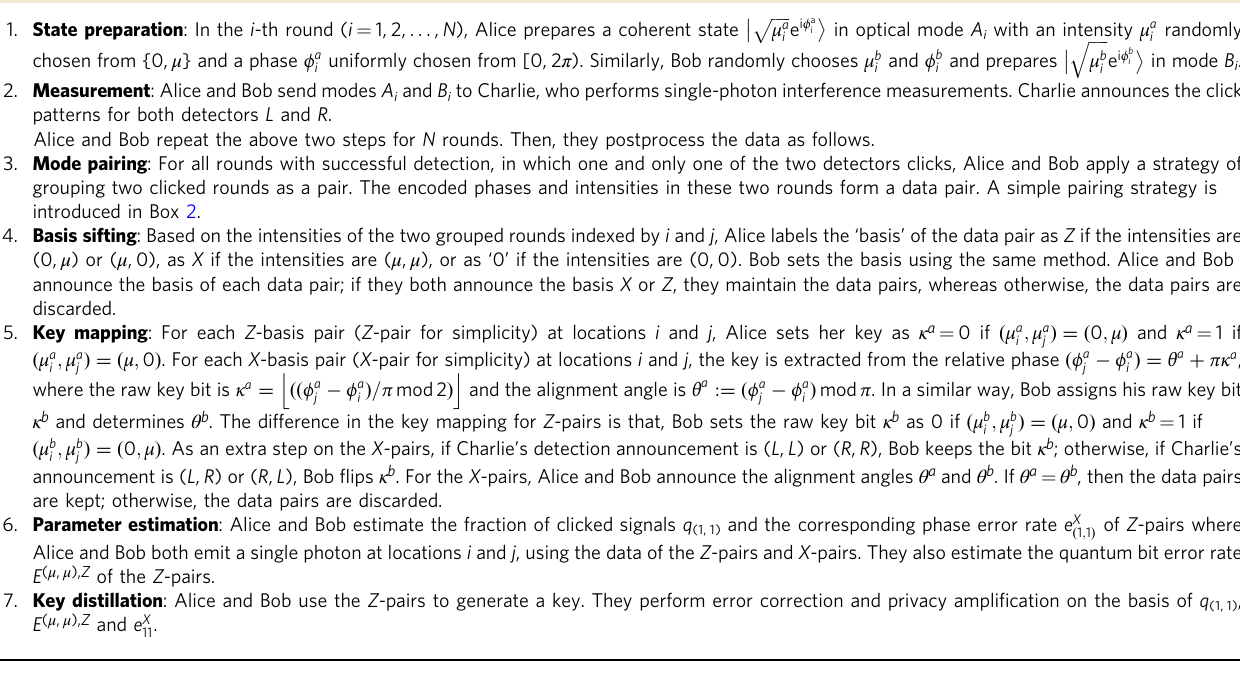
Box 1 | Mode-pairing